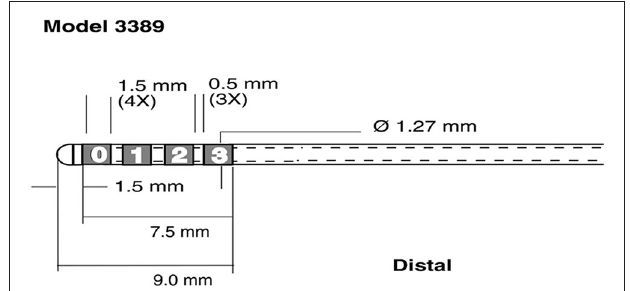
FIGURE 1 | Schematic representation of recording electrodes used for Local Field Potential (LFP) recordings . Medtronic 3389 DBS lead (reprinted with the permission of Medtronic, Inc. © 2008). The four leads were rearranged into 3 bipolar pairs C1 = 1-0, C2 = 2-1 C3 = 3-2 for each